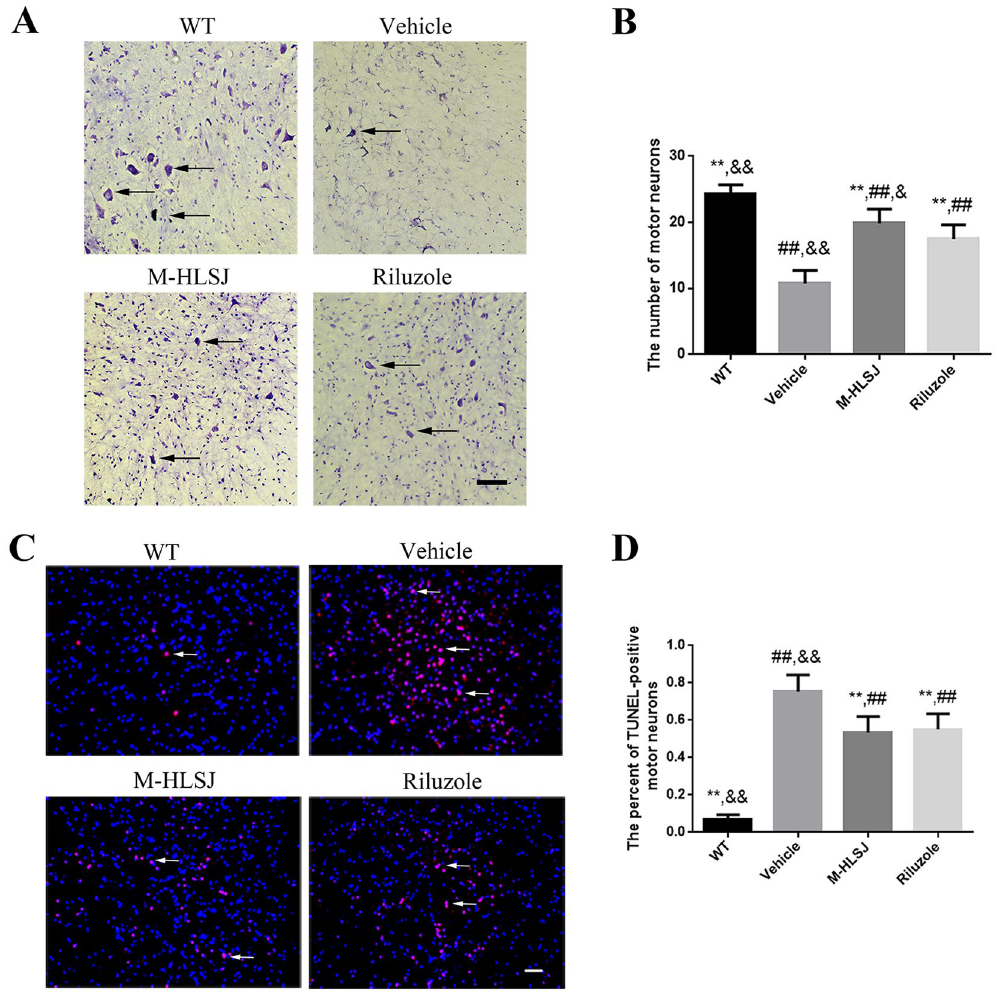
Figure 4. Effects of HLSJ on the survival and apoptosis of motor neurons in the anterior horn of the lumbar spinal cords. ( A) The nissl staining of the motor neurons (black arrows) in the anterior horn of L4-L5 lumbar spinal cords, scale bar = 50 μ m. ( B ) The comparing results of the number of motor neurons in the anterior horn of L4-L5 lumbar spinal cords, n = 150 in each group. ( C ) The photomicrographs of TUNEL-staining (white arrows) in the lumbar spinal cords, n = 30 in each group, scale bar = 50 μ m. ( D ) The percent of TUNEL- positive neurons in the lumbar spinal cords. Significant differences with vehicle group at ** P < 0.01. Significant differences with WT group at ## P < 0.01. Significant differences with riluzole group at & P < 0.05 and && P <